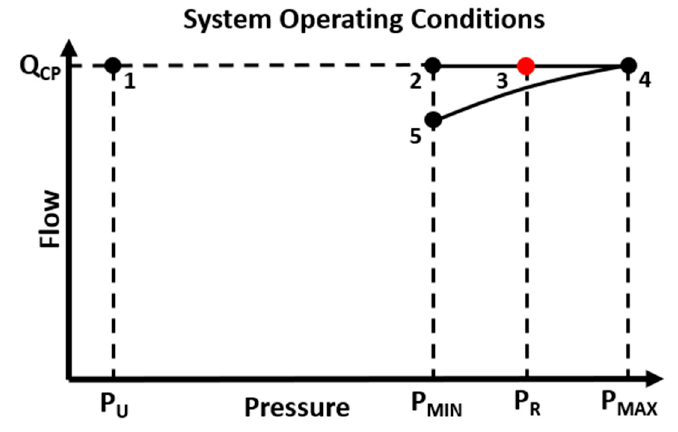
Figure 4. LP hydraulic power consumption.